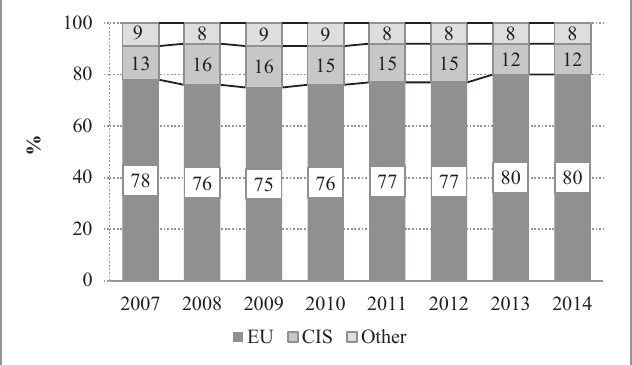
Fig. 3. Import structure of Latvian goods, for groups of countries, in % (CSB of